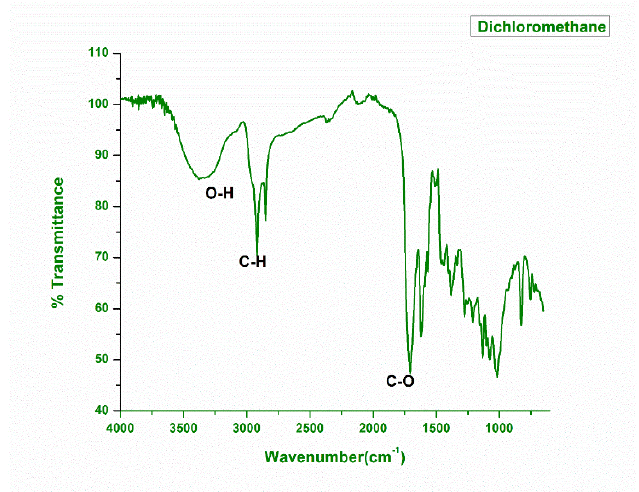
Figure 1. FTIR analysis of DCM extract of plant Nymphaea Mexicana Zucc. The presence of an O-H peak reflects the presence of polyphenols in this extract, in which the O-H group interacts with the DCM solvent through hydrogen bonding. Similarly, the importance of the C=O peak suggests the presence of those compounds that contain oxo functional groups in their structures, such as aldehydes and